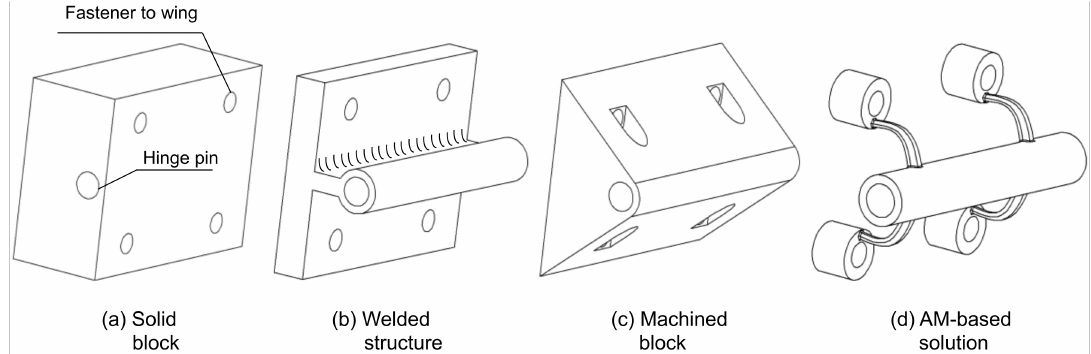
Figure 7. Aircraft hinge plate designs according to various manufacturing processes including